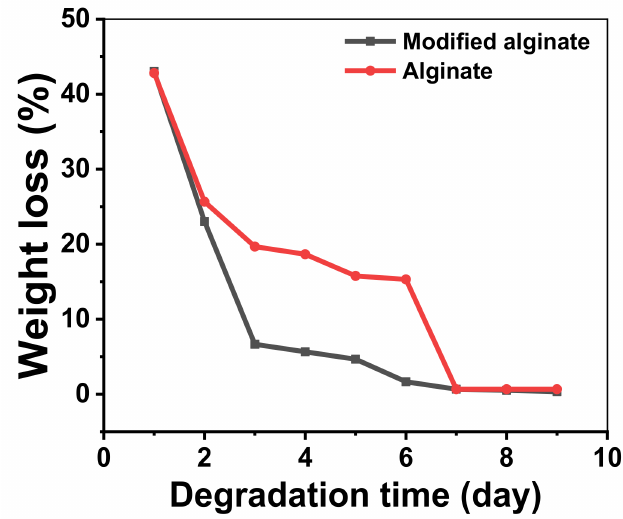
Figure 7. Hydro degradability of alginic acid and its aromatic